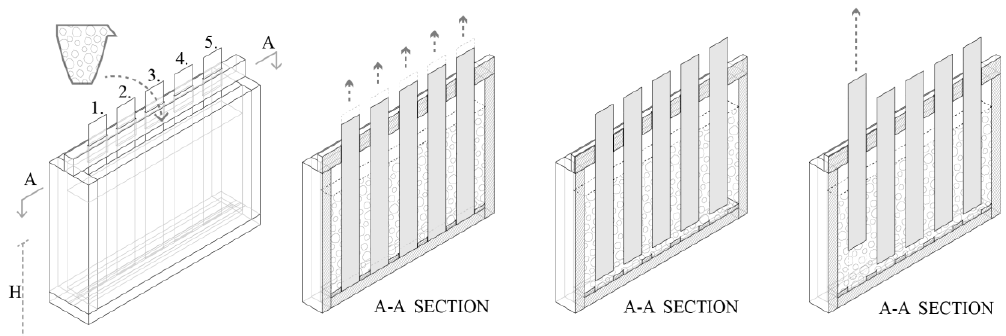
Figure 2. Left: friction test box is filled with concrete. Middle left and right: section of the friction tests box showing the guiding piece on top, the slit in the bottom and the final position of the strips before testing. Right: friction test performed on the first strip.